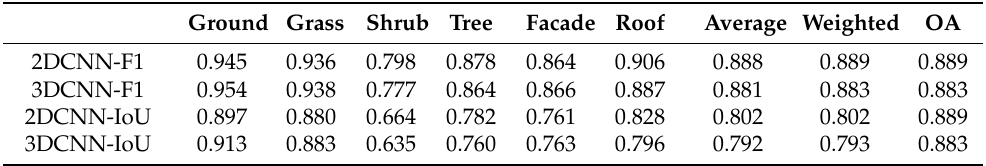
Table 11. Average and weighted F1 and IoU scores for 2DCNN and 3DCNN classifiers for the 3DOMCity dataset. The OA is also